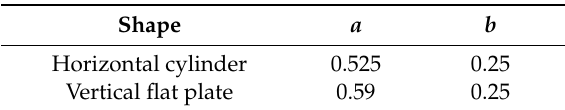
Table 5. Natural convection correlation coefficients